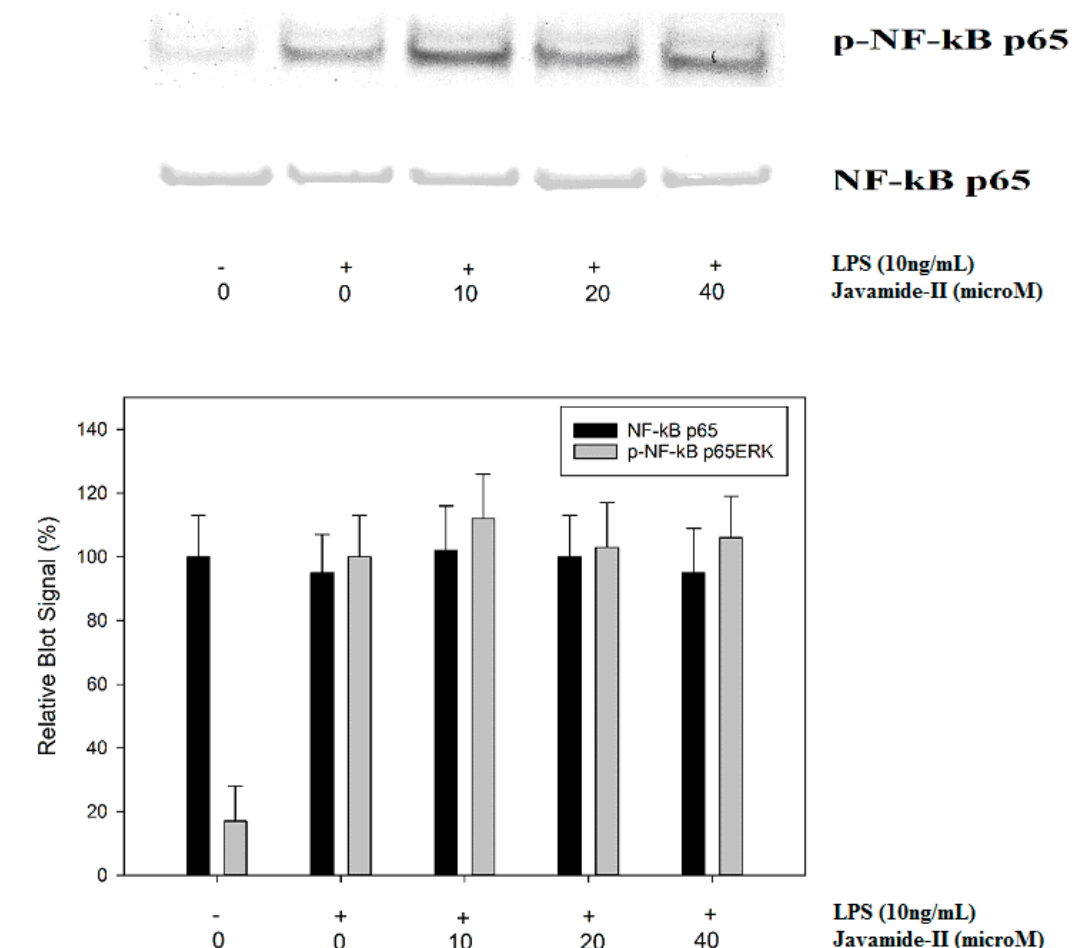
Figure 6. The effect of javamide-II on p65 NF- κ B phosphorylation PMA-differentiated THP-1 cells were treated with javamide-II (0, 10, 20, 40 µM) followed by treatment with LPS for 45 min, and the nuclear extract samples for blots were prepared as described in “Materials and Methods”.